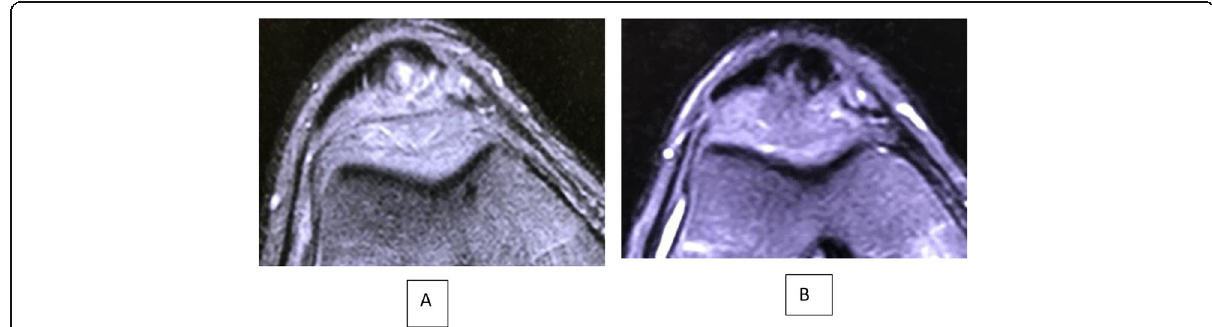
Fig. 7 A Pre-injection axial STIR MR image showing injury of the patellar tendon and B : 6 months Post-injections axial view MRI showing partial healing of the tendon